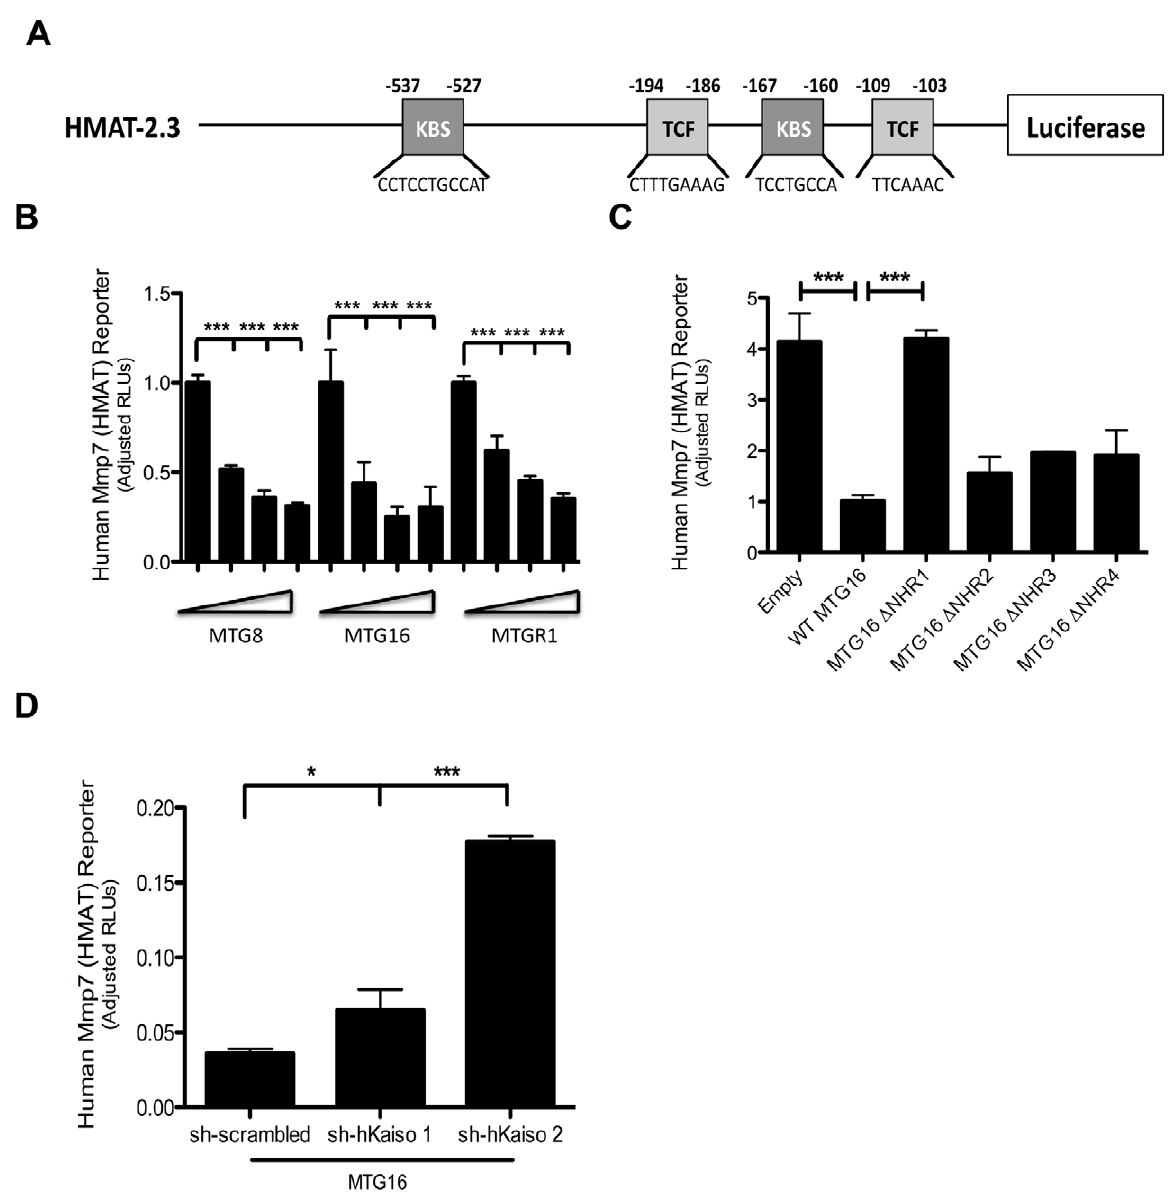
Figure 4. MTG family members depend on Kaiso to repress the human MMP-7 promoter. A. The composition of the full-length MMP-7 reporter (HMAT-2.3). The HMAT-2.3 reporter contains two Kaiso and two TCF binding sites followed by a luciferase gene. B. HMAT-2.3 artificial promoter assays in HCT116 cells upon titration of MTG family members (0 ng, 200 ng, 400 ng, 800 ng). The graph shows the fold-change in luciferase activity relative to the control reporter, pGL4-TK hRLUC, after transfection of expression plasmids encoding MTG family members, MTG8, MTG16, and MTGR1. The error bars represent the standard error of the mean for 3 replicate experiments performed in triplicate. C. HMAT-2.3 promoter assay utilizing MTG16 deletion constructs in which the indicated nervy homology region is removed. Error bars represent the standard deviation of triplicate samples. D. HMAT-2.3 artificial promoter assay after knockdown of Kaiso and the transfection of 500 ng of MTG16. Error bars represent the standard deviation of triplicate samples. * P , 0.05, *** P , 0.001.